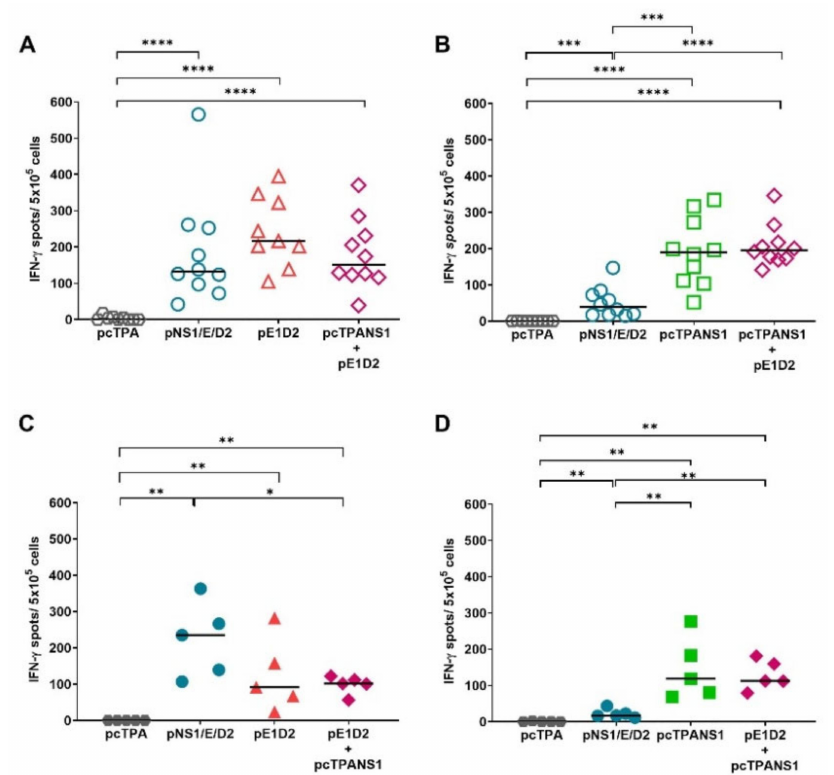
Figure 6. Production of IFN- γ by splenocytes from DNA vaccinated BALB/c mice. Quantifica- tion of IFN- γ production by ELISPOT assays using cells from mice immunized with the plasmids pNS1/E/D2, pcTPANS1, pE1D2, and pE1D2 + pcTPANS1, or with the negative control pcTPA ( n = 5–10). Splenocytes isolated 2 ( A , B ) or 4 weeks ( C , D ) after the second immunization were incu- bated in triplicate with ( A ) synthetic peptide 331 SPCKIPFEI 339 contained in the DENV2 E protein or ( B ) 265 AGPWHLGKL 273 contained in the DENV2 NS1 protein, both recognized by CD8 + T cells; ( C ) pool of 15-mer E-derived peptides or ( D ) pool of 15-mer NS1 derived peptides, with both pools containing peptides that can be recognized by CD4 + and CD8 + T cells. Values are expressed as the number of spot-forming cells, and bars represent the median of the obtained values. Asterisks indicate statistically significant differences between experimental groups using non-parametric two-tailed Mann-Whitney statistical tests (* p < 0.05; ** p < 0.01; *** p < 0.001; and **** p < 0.0001). The clinical signs of infection were classified on an arbitrary morbidity scale, rang- ing from 0 to 4 degrees, concerning mainly leg paralysis and commitment of the spinal column with different severity degrees (Figure 7C). The group of pcTPANS1-immunized animals showed varying degrees of morbidity but was statistically different from the pcTPA- inoculated or non-immunized control groups. On the other hand, the morbidity observed in pNS1/E/D2- and pE1D2-immunized animal groups did not exceed degree 2. Furthermore, no morbidity was detected in animals immunized with the mixture pE1D2 + pcTPANS1. These results reinforce the protection generated after immunization with DNA vaccines mediating the simultaneous expression of the NS1 and E